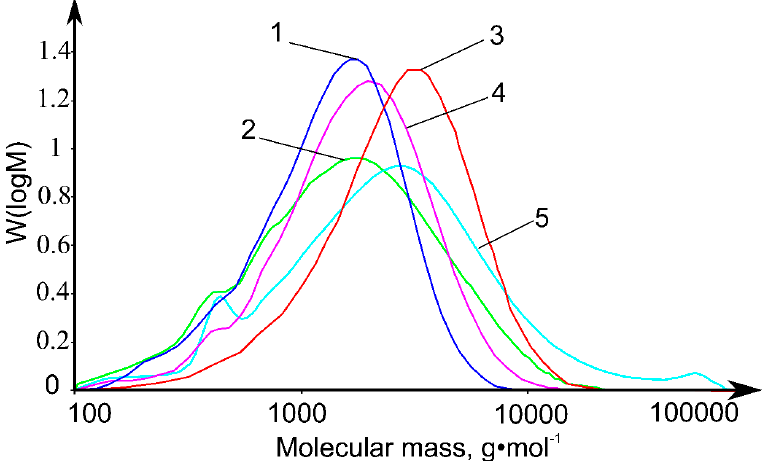
Figure 1. Molecular weight distributions of the lignin preparations isolated with [bmim]OAc ( 1 ),